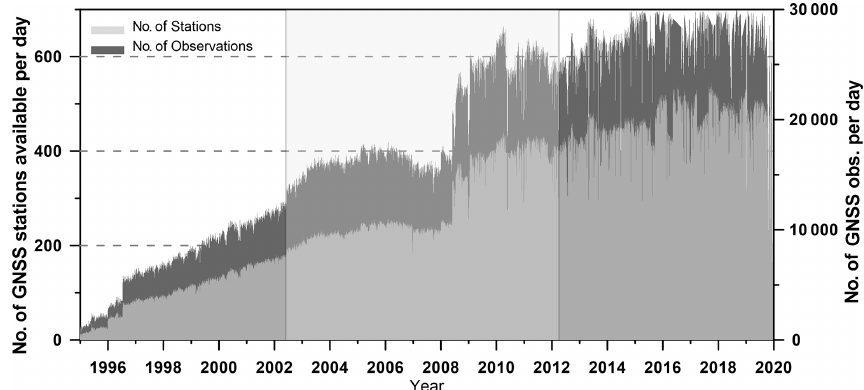
Figure 1. Number of GNSS stations used in GPD + over time (light grey) and number of available GNSS observations per day (dark grey), for the whole RA era. Envisat period (May 2002–March 2020) is shown by the shaded rectangle. All GNSS stations are at a distance from the coast of less than 100km. Table 1. Total column water vapour (TCWV) availability. For gridded products, two grids per day are made available, each grid comprising the ascending and descending passes. For the swath products, 14–15 orbital swaths per day are available for each instrument. For these latter products, the value provided for the spatial resolution is that of the central pixel (maximum value for pixel size is 130km). Satellite/sensor Spatial res. Temporal